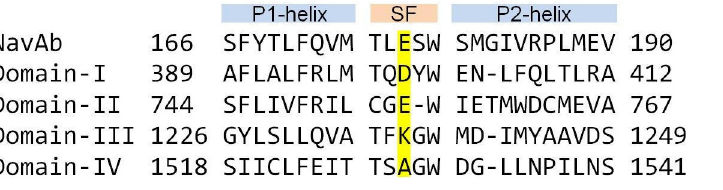
Fig 1. Alignment used in homology modeling of Na V 1.4. The DEKA residues in the four domains forming the selectivity filter (SF) are highlighted.